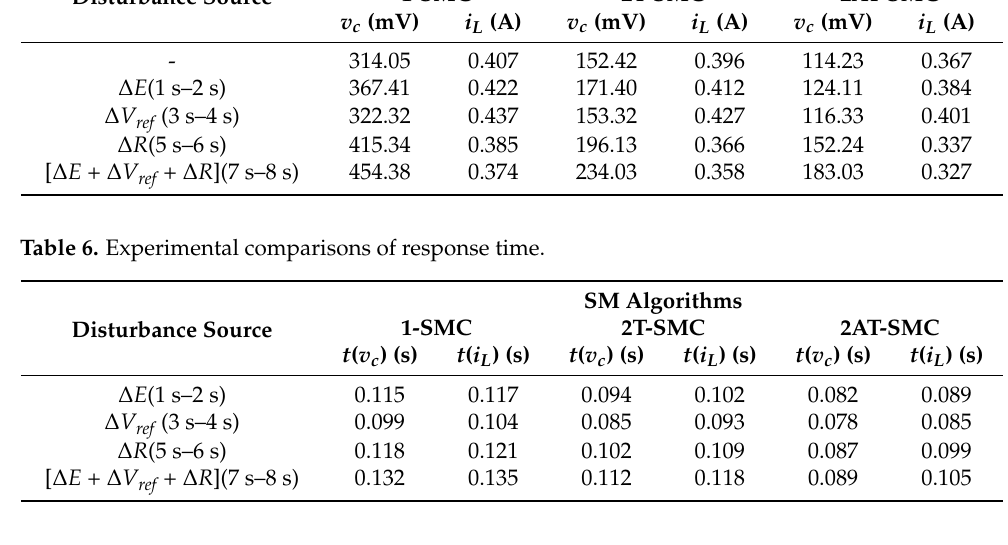
Table 5. Experimental comparisons of steady error.